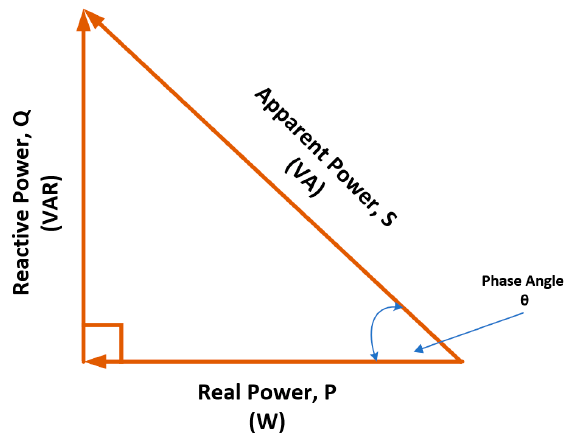
Figure 2. Power triangle of AC power system.